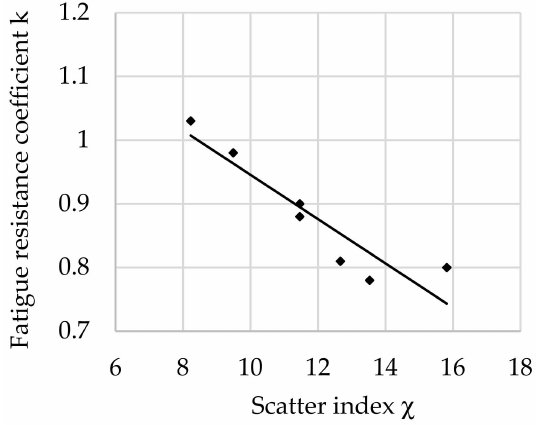
Figure 5. The relationship between the fatigue resistance coefficient and scatter index of structural steel hardened and tempered at 300 ◦ C.